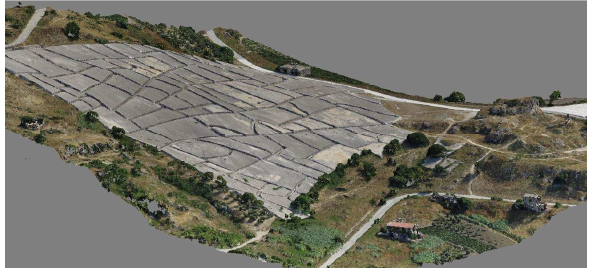
Figure 9. 3D model of the “Cretto of